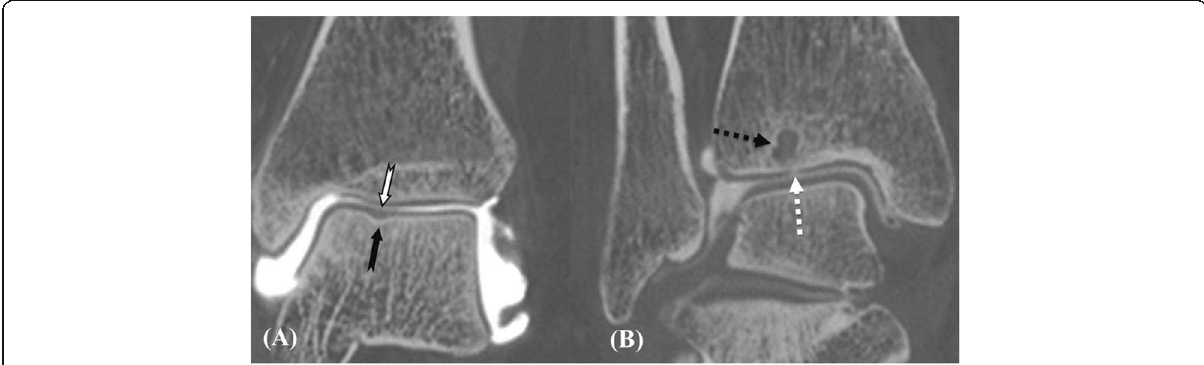
Fig. 8 Coronal CTA images of two different patients had chronic lateral ankle pain. a Focal compression of talar subchondral bone plate (black arrow), with intact overlying cartilage (white arrow) compatible with type I talar OCL. b Focal tibial subchondral cystic changes (black arrow), with overlying cartilage defect (white arrow) compatible with type IIA OCL